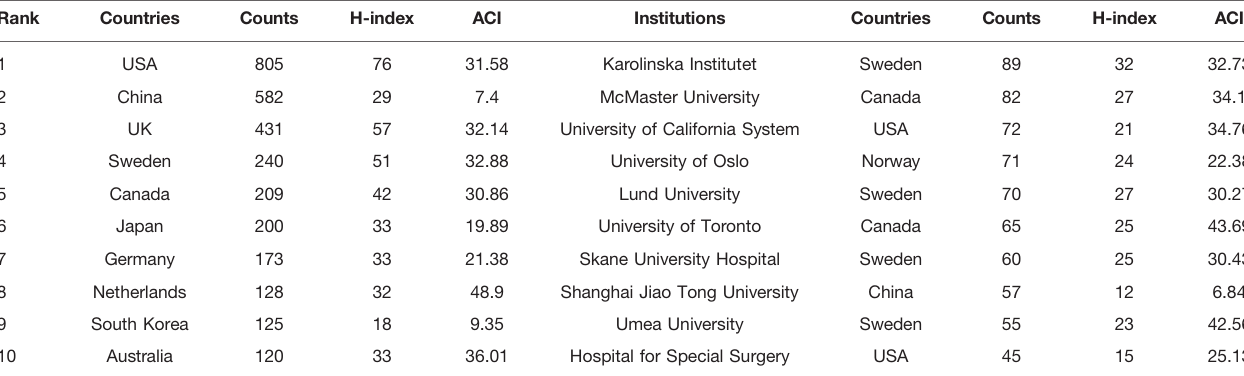
TABLE 1 | The top 10 countries and institutions with the most publications related to FNF